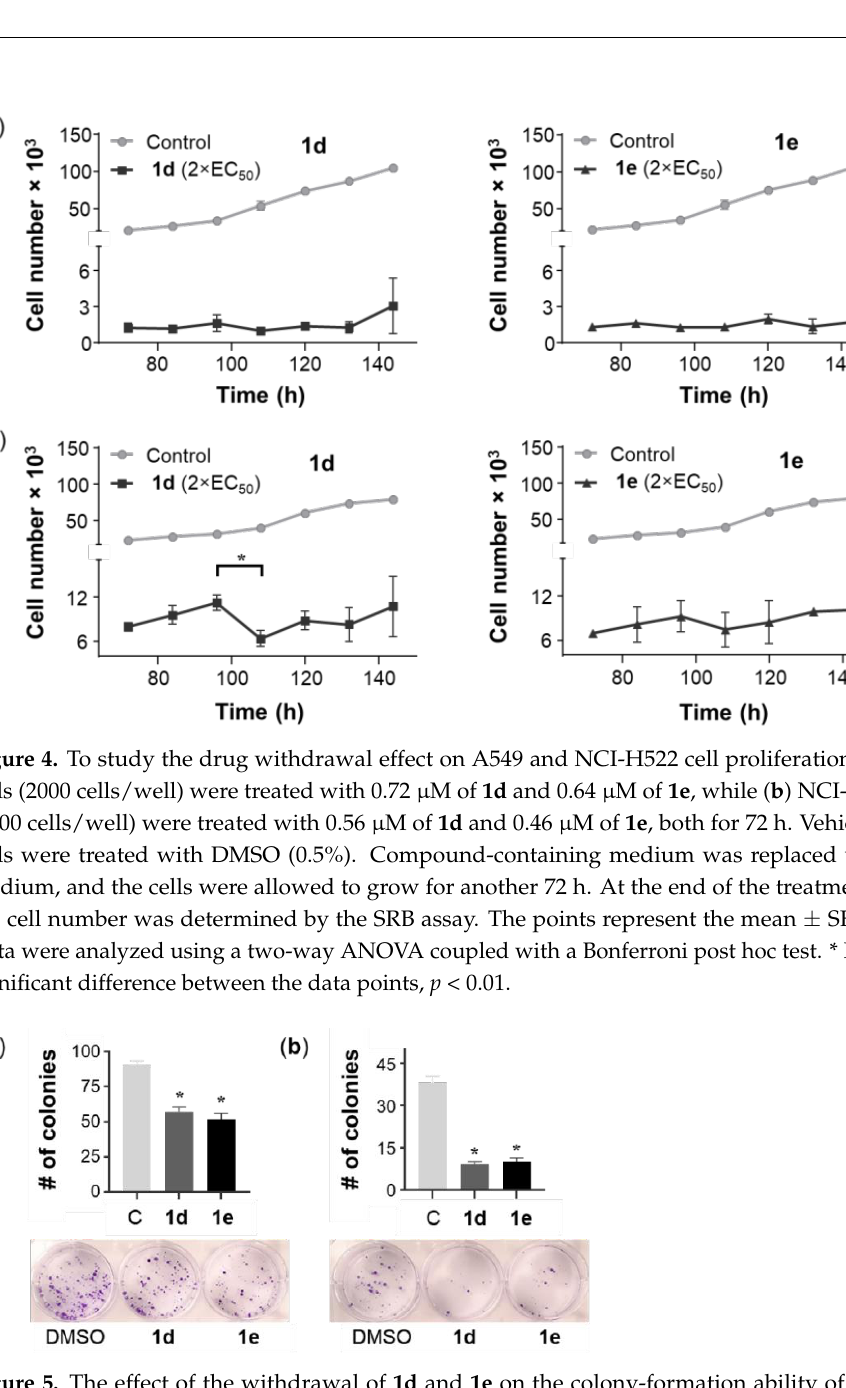
Figure 5. The effect of the withdrawal of 1d and 1e on the colony-formation ability of A549 and NCI-H522 cells. ( a ) A549 cells were treated with 0.72 µ M of 1d and 0.64 µ M of 1e , while ( b ) NCI-H522 cells were treated with 0.56 µ M of 1d and 0.46 µ M of 1e , each for 72 h. Vehicle control cells were treated with DMSO (0.5%). The A549 and NCI-H522 (2 × 10 2 and 5 × 10 2 cells, respectively) cells were then seeded in 6-well plates for 14 and 21 days, respectively, and the medium was changed every three days. Single-colony formation was determined by crystal violet staining. Bars represent the mean ± SEM ( n = 3). Data were analyzed with a one-way ANOVA coupled with a Bonferroni post hoc test. * Indicates significant differences to control, p <